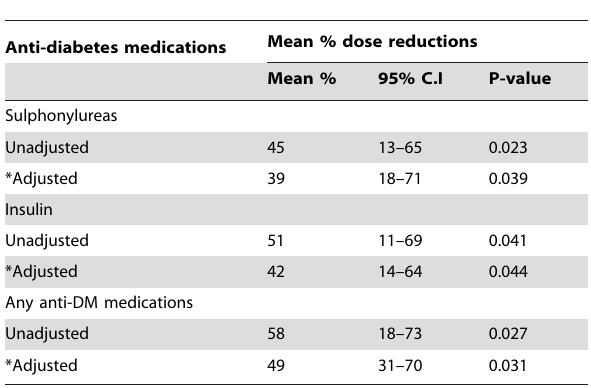
Table 5. Linear regression analysis associating percentage weight loss (every 5%) and mean % dose reductions of anti- diabetes medications (entire cohort).